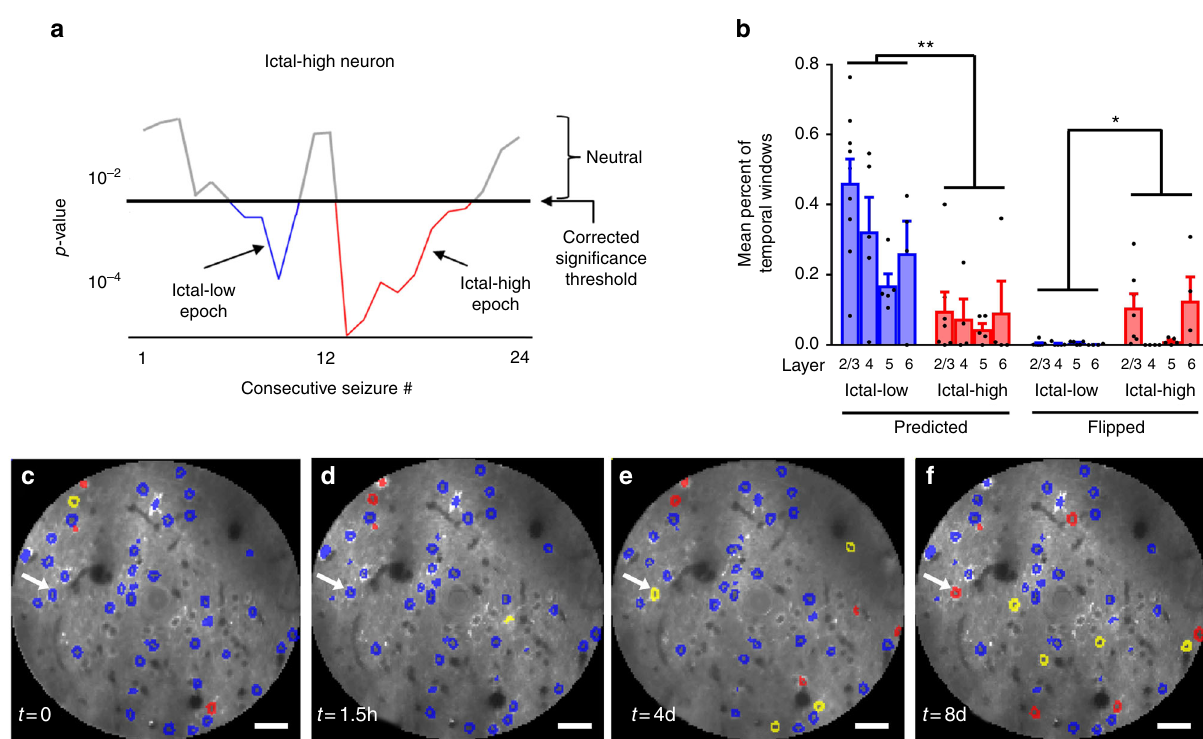
Fig. 3 Temporal participation of neurons over minutes to days. a With a 7-minute moving window, a neuron with an overall classi fi cation of “ ictal-high ” had 1 signi fi cant ictal-high segment (red), periods of no signi fi cant difference (gray), and it also fl ipped to have 1 brief ictal-low epoch (blue). b Temporal windows were more often in the predicted than the fl ipped classi fi cation. In addition, ictal-low neurons had a smaller proportion of fl ipped classi fi cations than ictal-high neurons (* p = 0.028, ** p < 0.001). Bar plots: mean (±s.e.m.). c Distribution of ictal-high and ictal-low neurons in one data set, d 90 min later, e after 4 days, and f after 8 days in the same chronically imaged window. Note, for example, that one neuron starts as ictal-low but then becomes neutral after 4 days and ictal-high after 8 days (arrow). Blue = Ictal-low, red = Ictal-high, yellow = neutral, uncolored = quiet (neurons with exceptionally low average activity in at least one of the four time points; Methods). Horizontal scale bars in c – f : 35 µ